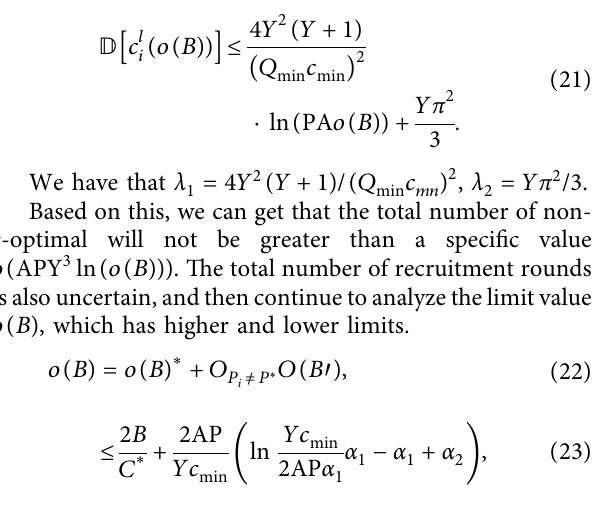
the total number of rounds executed by the user recruitment algorithm under the budget B limit. The obtained